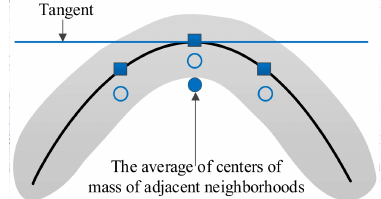
Figure 2. Improved method by Sauer